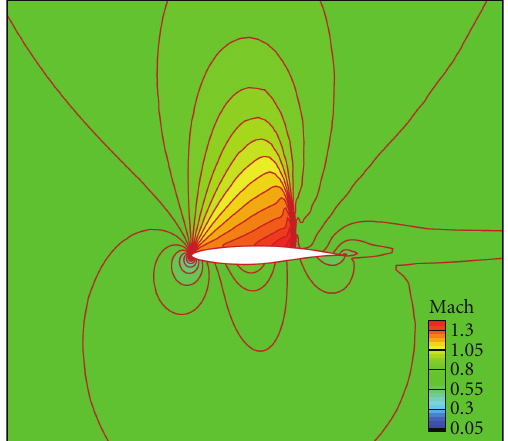
Figure 4: Initial (unadapted) surface mesh of ONERA M6 wing.